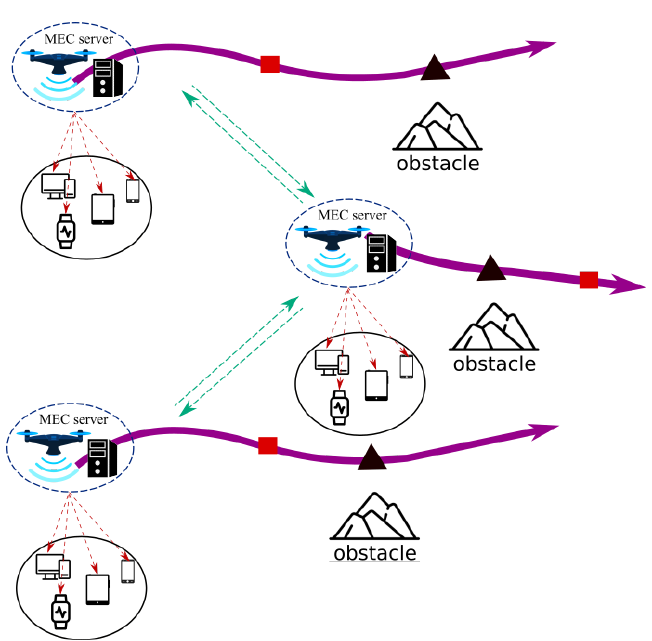
Figure 1. Assisted MEC architecture.